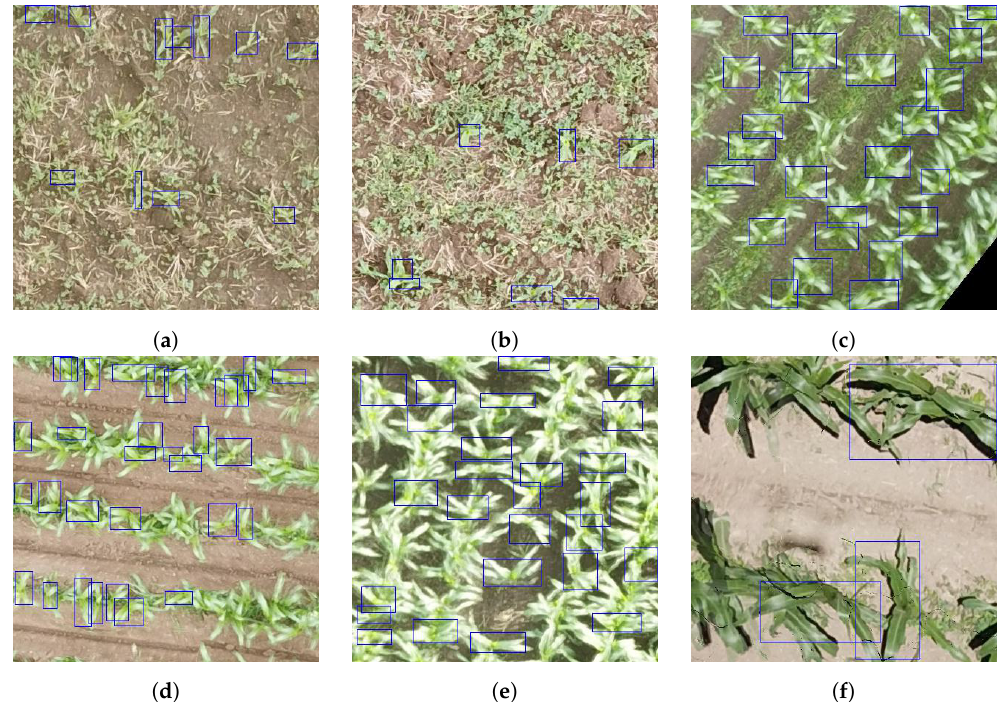
Figure 2. Manually labeled image samples. ( a , b ) correspond to Irrigación with corn at stage V 4 0.33 , ( c ) to San Juan A2 with corn at stage V 8 1.00 , ( d ) to Xerona with corn at stage V 6 1.00 , ( e ) to Ranchito X13 with corn at stage V 7 1.00 and ( f ) to Irrigación with corn at stage V 6